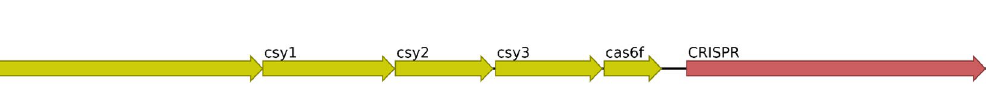
Figure 4. Mauve alignment of five L. longbeachae reference plasmids.